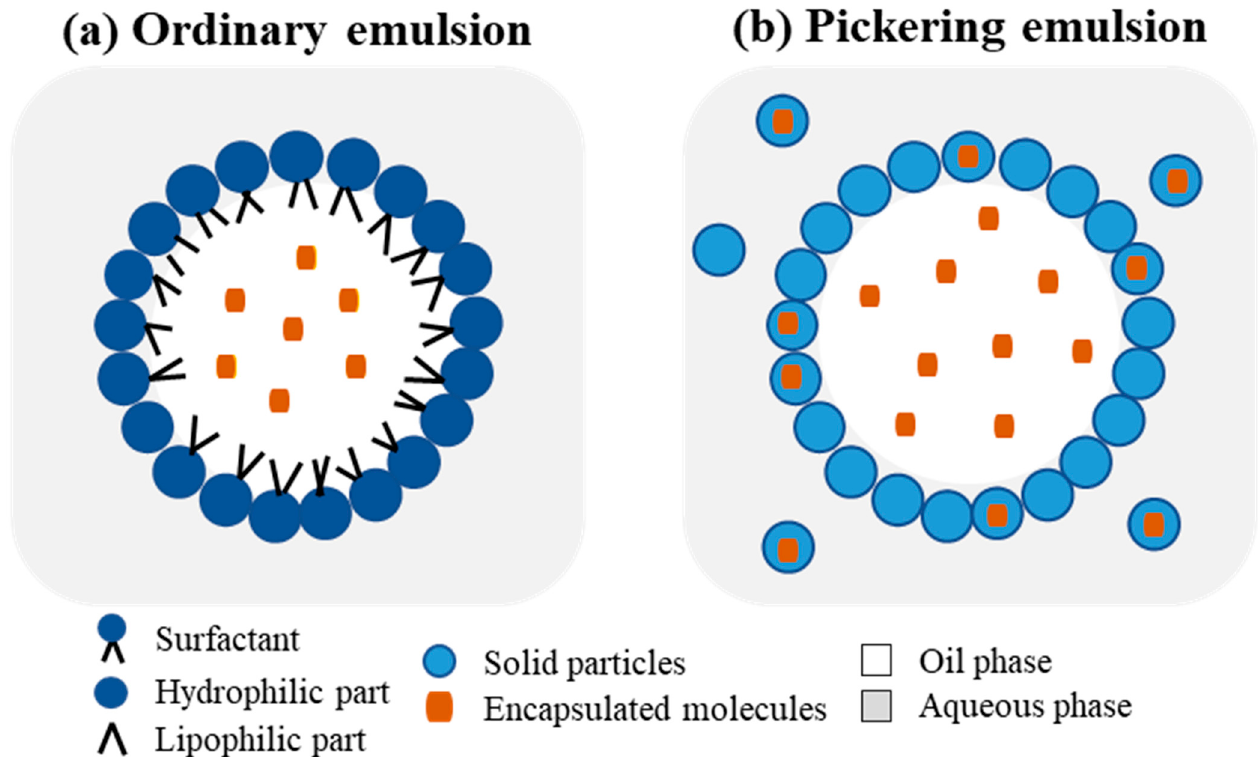
Figure 7. Schematic representation of ( a ) ordinary emulsion stabilized by surfactant and ( b ) Pickering emulsion stabilized by solid particles.